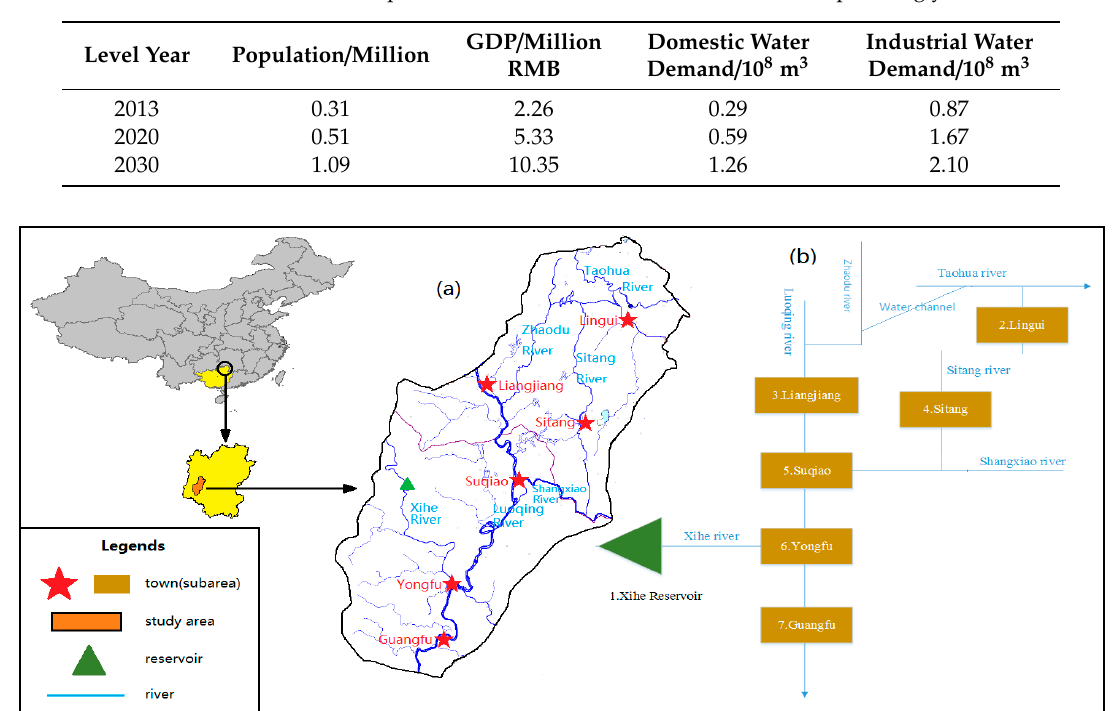
Table 1. Economic development index and water demands in different planning years.